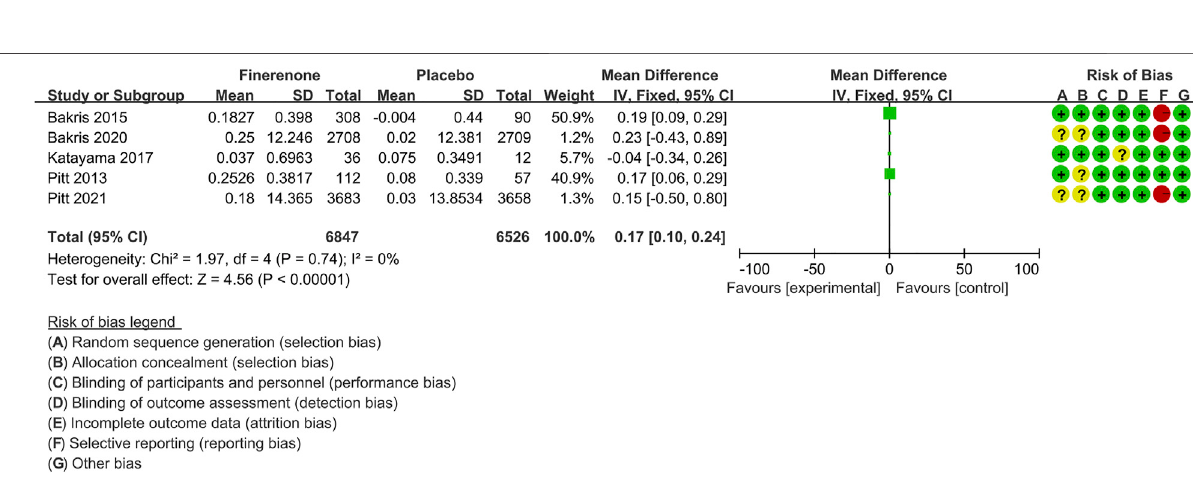
7,019) versus placebo (n = 6,660) groups. As shown in Figure 10 , the proportion did not show any difference in fi nerenone and placebo [RR 1.00 (95% CI 0.98 – 1.01), p = 0.67].